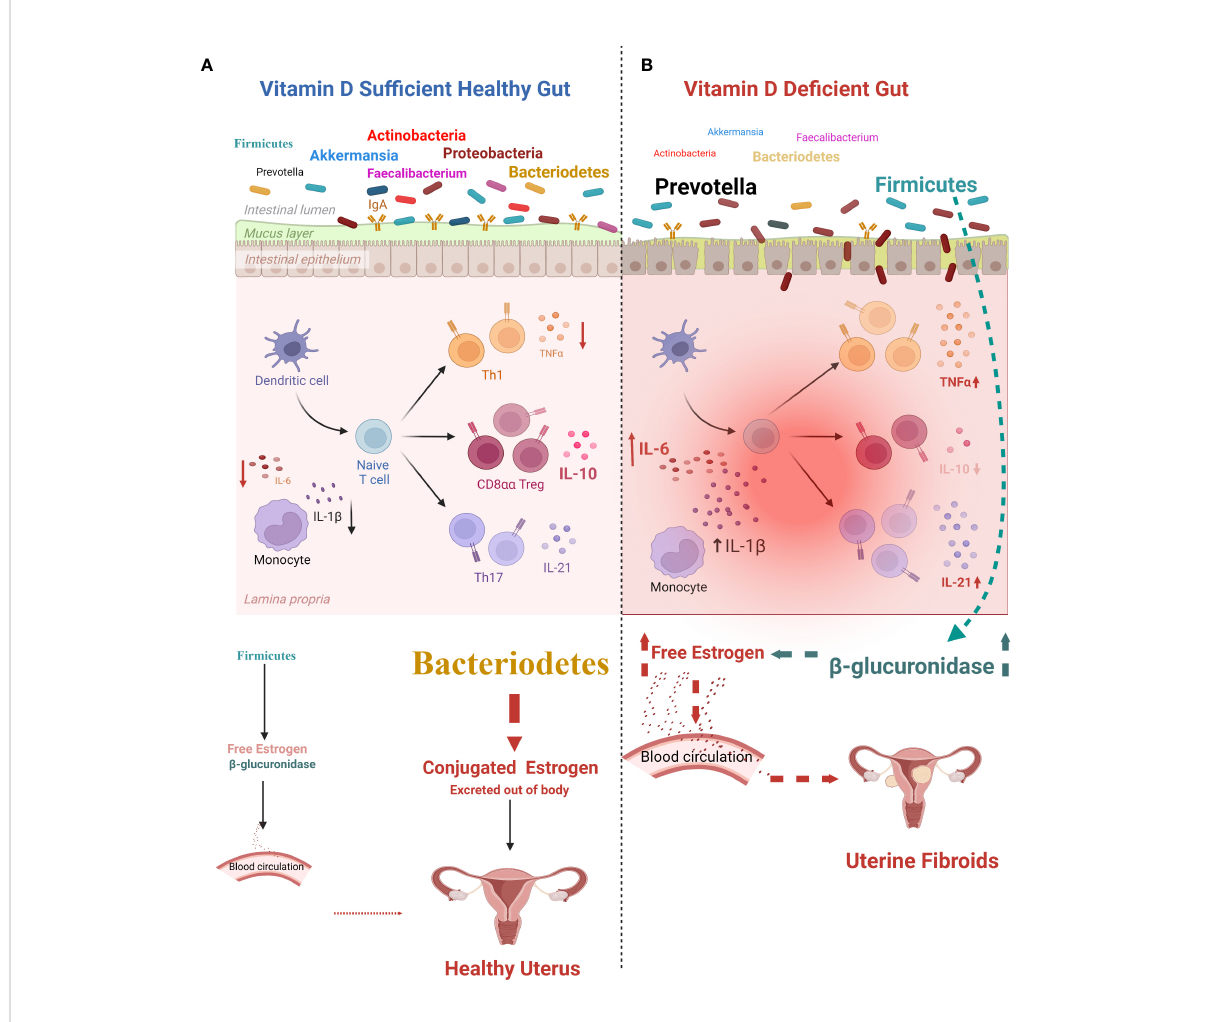
FIGURE 4 Effects of vitamin D on the gut and estrogen metabolism. (A) Effect of vitamin D suf fi ciency: healthy gut. Dominant gut bacteria (including Bacteroidetes) are anti-in fl ammatory, preserve gut homeostasis, and maintain estrogen metabolite levels, decreasing the incidence of